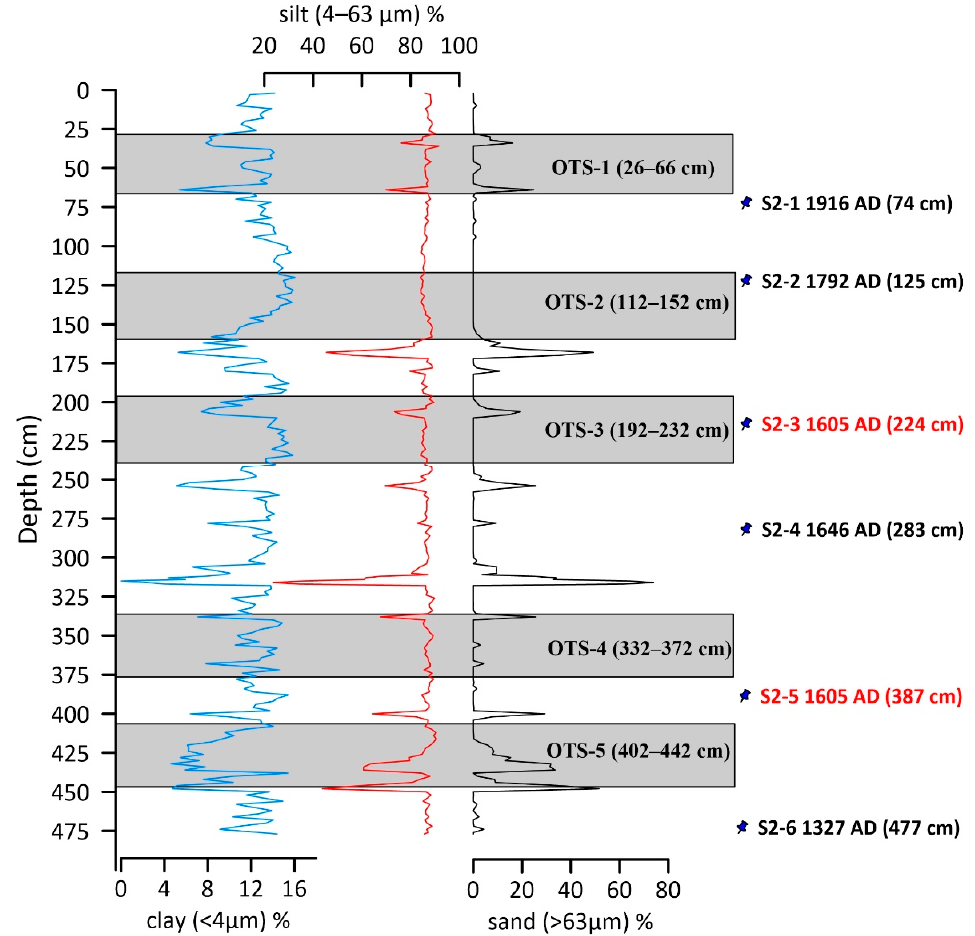
Figure 2. Location diagram of heavy mineral assemblage samples. Grain size composition is quoted from reference [20]. Sampling locations are marked by gray rectangles.